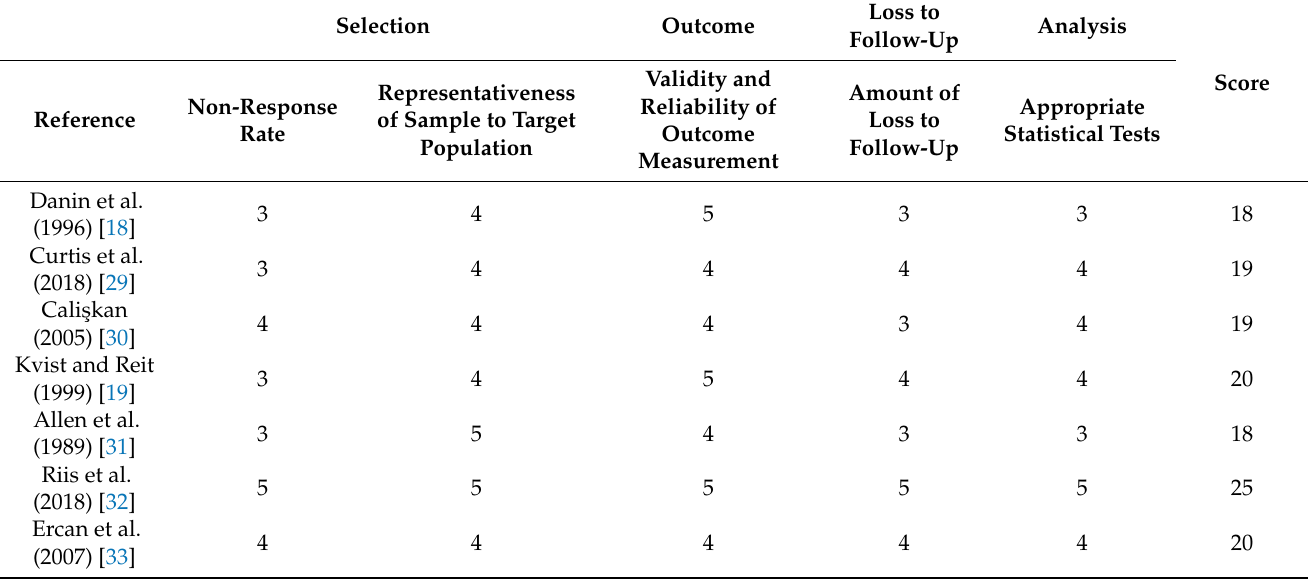
Table 3. Assessment of risk of bias within the